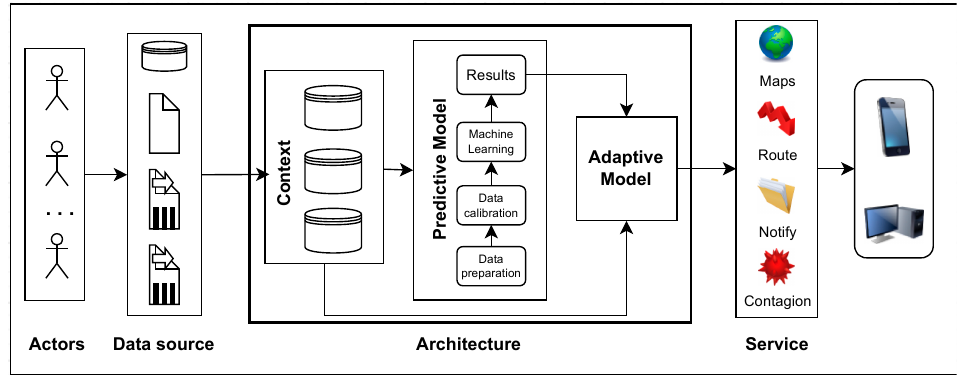
Figure 3. Adaptive and predictive system proposal: EiBeLec.